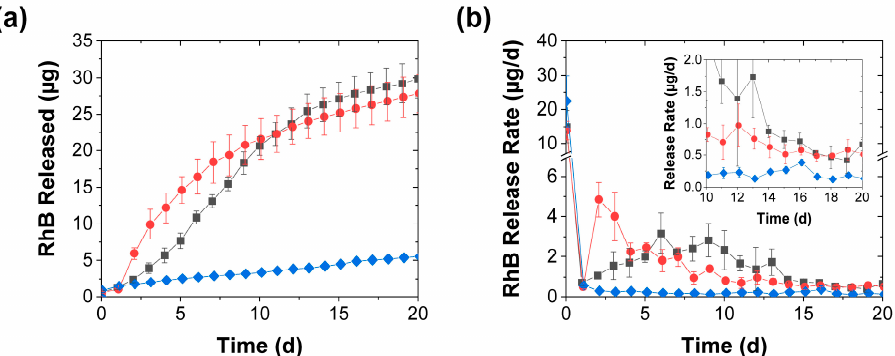
Figure 4. RhB release from coacervates into deionized water achieved with ( (cid:4) ) daily perforation with two needle jabs, ( • ) daily compression, and ( (cid:7) ) without mechanical stimulation and shown in terms of both ( a ) the total RhB mass released and ( b ) the release rate (mean ± SD). The inset provides a closeup of the slower release rates near the end of the experiment, while the lines are guides to the eye.